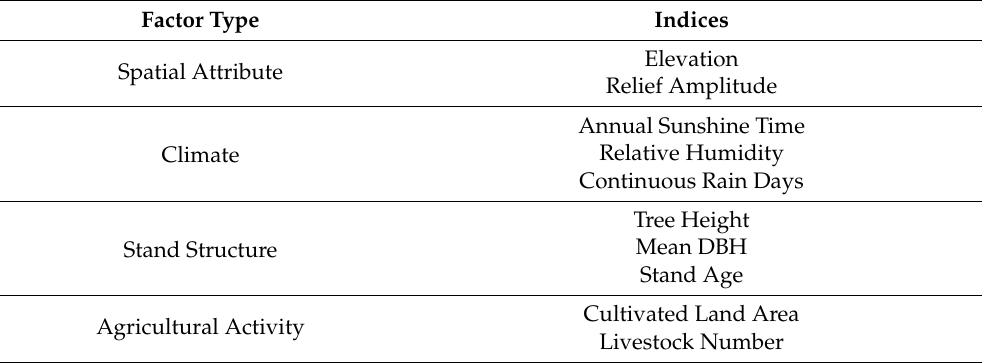
Table 2. List of driving